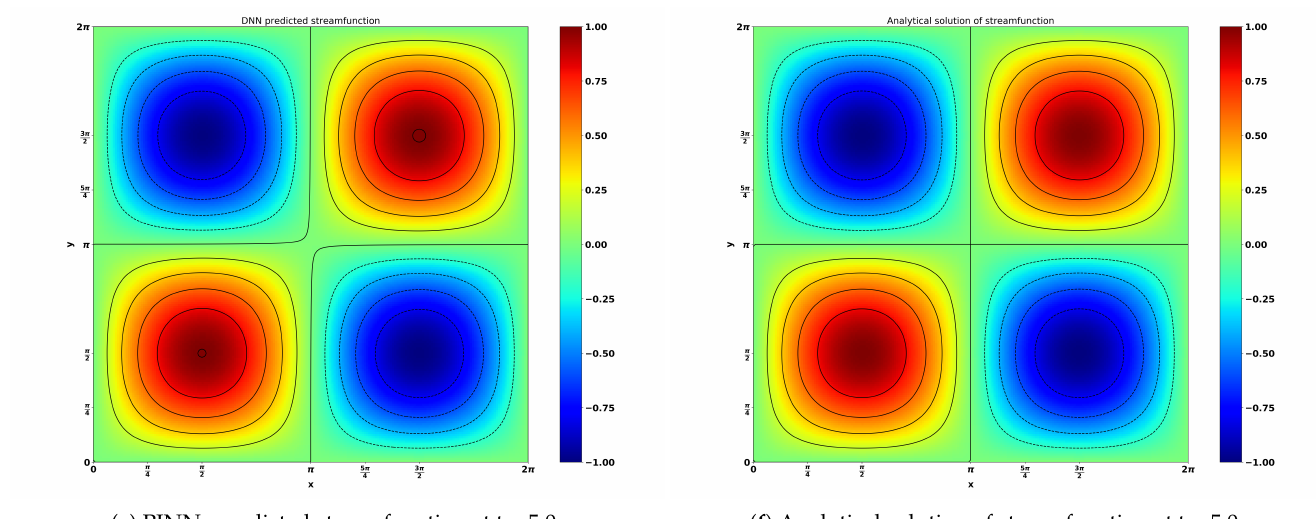
Figure 10. Predicted stream functions from PINNs ( left ) and analytical results ( right ).